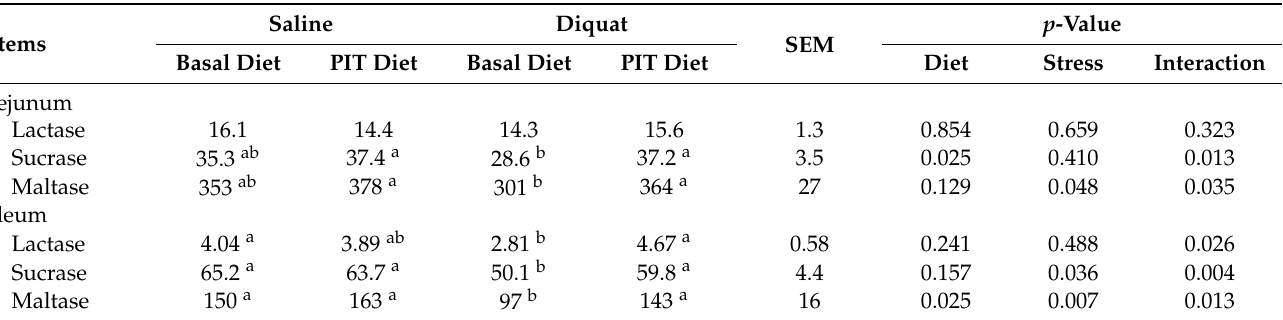
Table 4. The activities of intestinal mucosal disaccharidases of the piglets fed polyphenols sourced from Ilex latifolia Thunb. (PIT) diets under oxidative stress (U/mg protein).